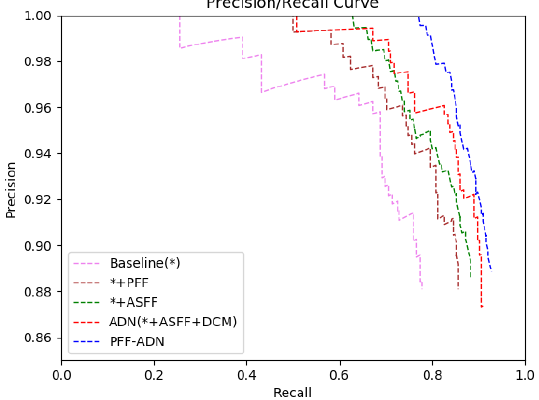
Figure 9. Effectiveness of the proposed PFF-ADN, which includes the PFF, the ASFF, and the ADN (ASFF + PFF). (*) denotes the baseline